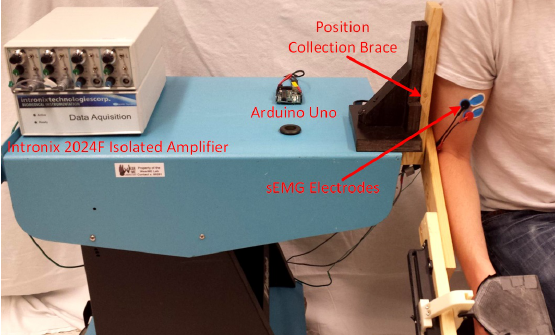
Figure 4. The data collection setup consists of the Intronix 2024F Isolated Amplifier and the elbow position collection brace. Bipolar surface EMG electrodes used by the amplifier to collect the electrical muscle activity. One pair of electrodes was placed over the skin covering each of the biceps brachii and triceps brachii muscles, while a single reference electrode was placed near the olecranon. Subjects were connected to the collection brace using Velcro straps (not shown) such that their elbow axis aligned with the rotational axis of the brace. An Arduino Uno was used to collect encoder data from the collection brace and stream it to a desktop